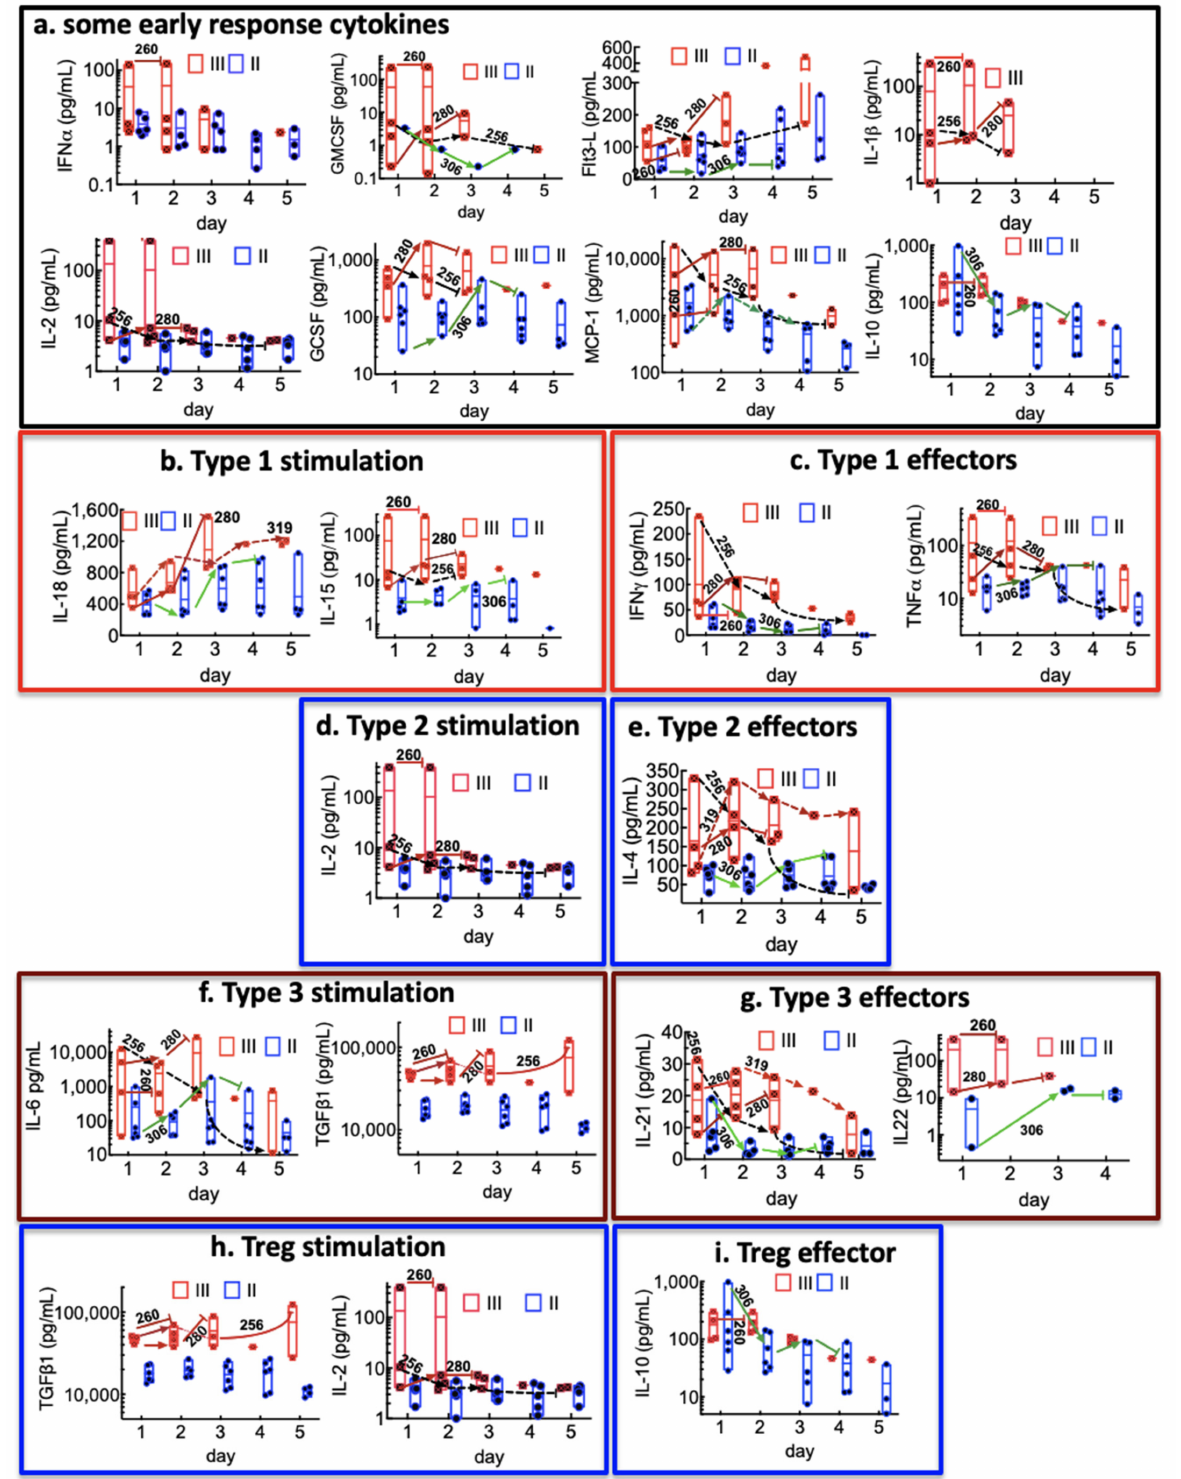
Figure 2. Overview of immunological features in HCPS patients in Class II (ECMO survivors) and Class III (terminal) patients. Arrows and the patient’s ID number indicate the longitudinal expression of the leukocytes for specific patients. ( a ) Plots of cytokines associated with early innate immune responses. ( b , c ) Cytokines associated with type 1 immunity. ( d , e ) Cytokines associated with type 2 immune response; ( f , g ) Type 3 immunity; ( h , i ) Treg